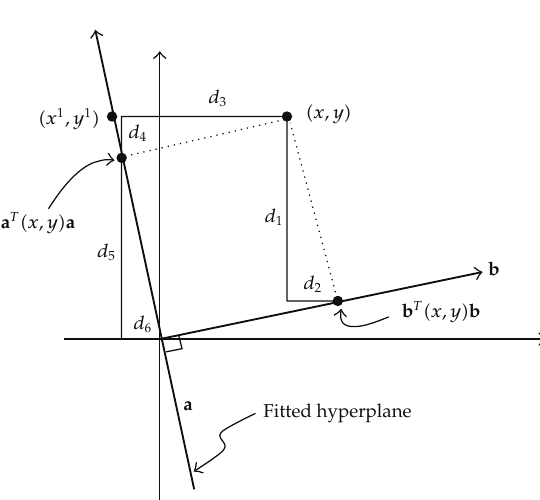
Figure 1: Two-dimensional illustration of di ff erent methods for incorporating the L 1 norm into orthogonal regression. In traditional orthogonal regression, the sum of distances of points (cid:2) x,y (cid:3) to b T (cid:2) x,y (cid:3) b is maximized, the sum of distances of points (cid:2) x,y (cid:3) to a T (cid:2) x,y (cid:3) a is minimized, and the sum of the magnitudes of a T (cid:2) x,y (cid:3) a is maximized. As noted in the text, each of these distance measures can be modified to incorporate the L 1 norm to derive di ff erent results. In this paper, the approach is to maximize the sum of L 1 distances of points (cid:2) x,y (cid:3) to b T (cid:2) x,y (cid:3) b which is illustrated by d 1 (cid:5) d 2